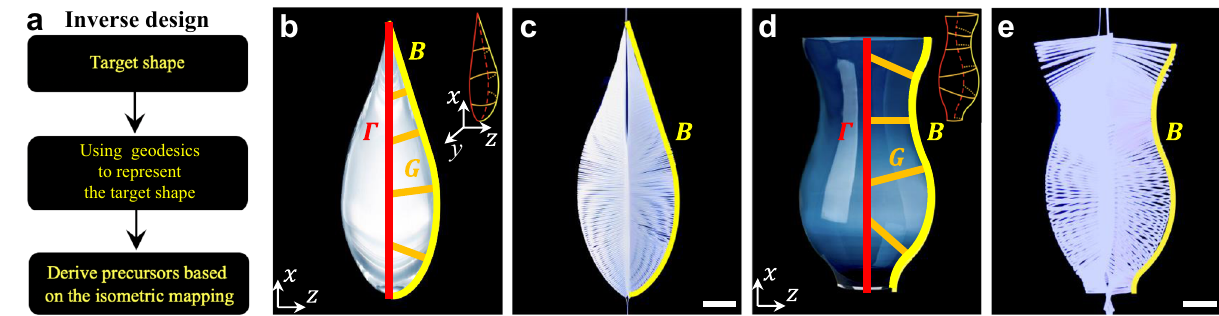
Fig. 5 Inverse design of 3D shapes. a Flow diagram of the inverse design. b Schematic of using curves to approximate and represent the target shape (side view of a waterdrop). The inset shows an isometric view. Red, orange, and yellow curves are the boundary curve Γ , geodesic curve G , and backbone curve B , respectively. c Experimental inverse-design result of the waterdrop shape formed by a 2D kirigami precursor subject to uniaxial tension. The yellow curve is the backbone in the target shape. d Schematic of using curves to approximate and represent the target shape (side view of a vase), with an isometric view showing in the inset. e Experimental inverse-design result of the vase shape formed by a 2D precursor subject to uniaxial tension. Scale bars = 10